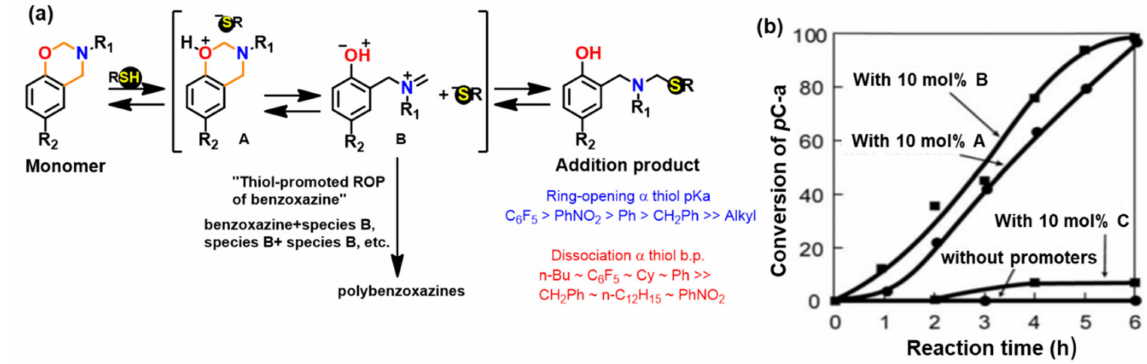
Figure 40. ( a ) Reversible reaction of benzoxazines and thiols [278,281]. ( b ) Time dependence of conversion of p C-a in its thermally induced polymerization in the presence of thiophenol (A), p -nitrothiophenol (B) and p-cresol (C) at 140 ◦ C [278]. Copyright 2014. Reproduced with permission from Wiley Periodicals, Inc.